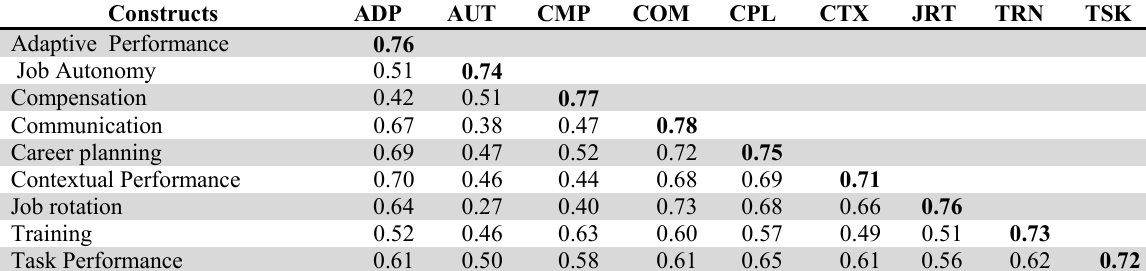
Correlations and square roots of AVE of latent variables